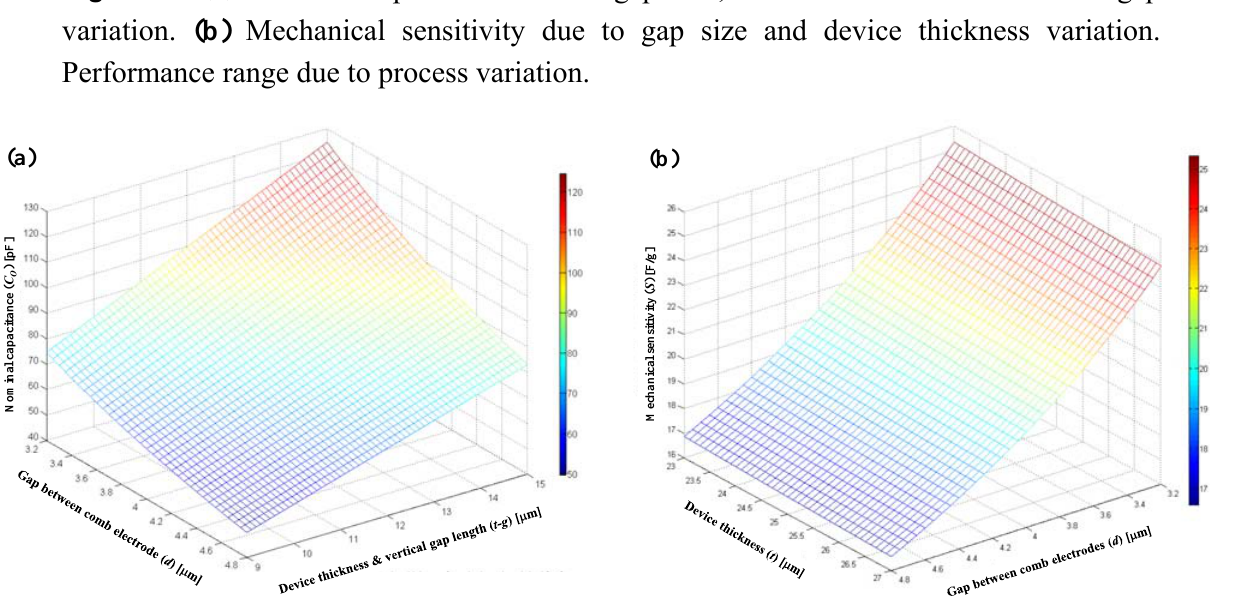
Figure 8. (a) Nominal capacitance due to gap size, device thickness and vertical gap variation. (b) Mechanical sensitivity due to gap size and device thickness